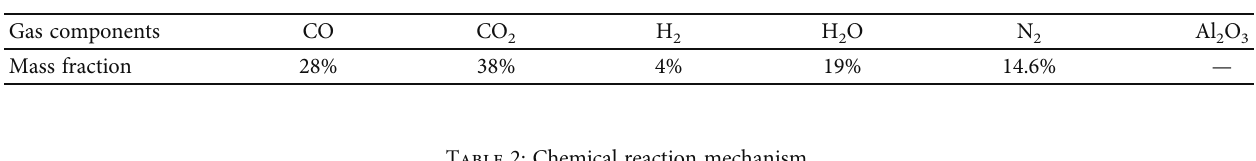
Figure 3: The three-dimensional grid: (a) global grid; (b) key area of grid. Table 1: Components of primary fl ow.